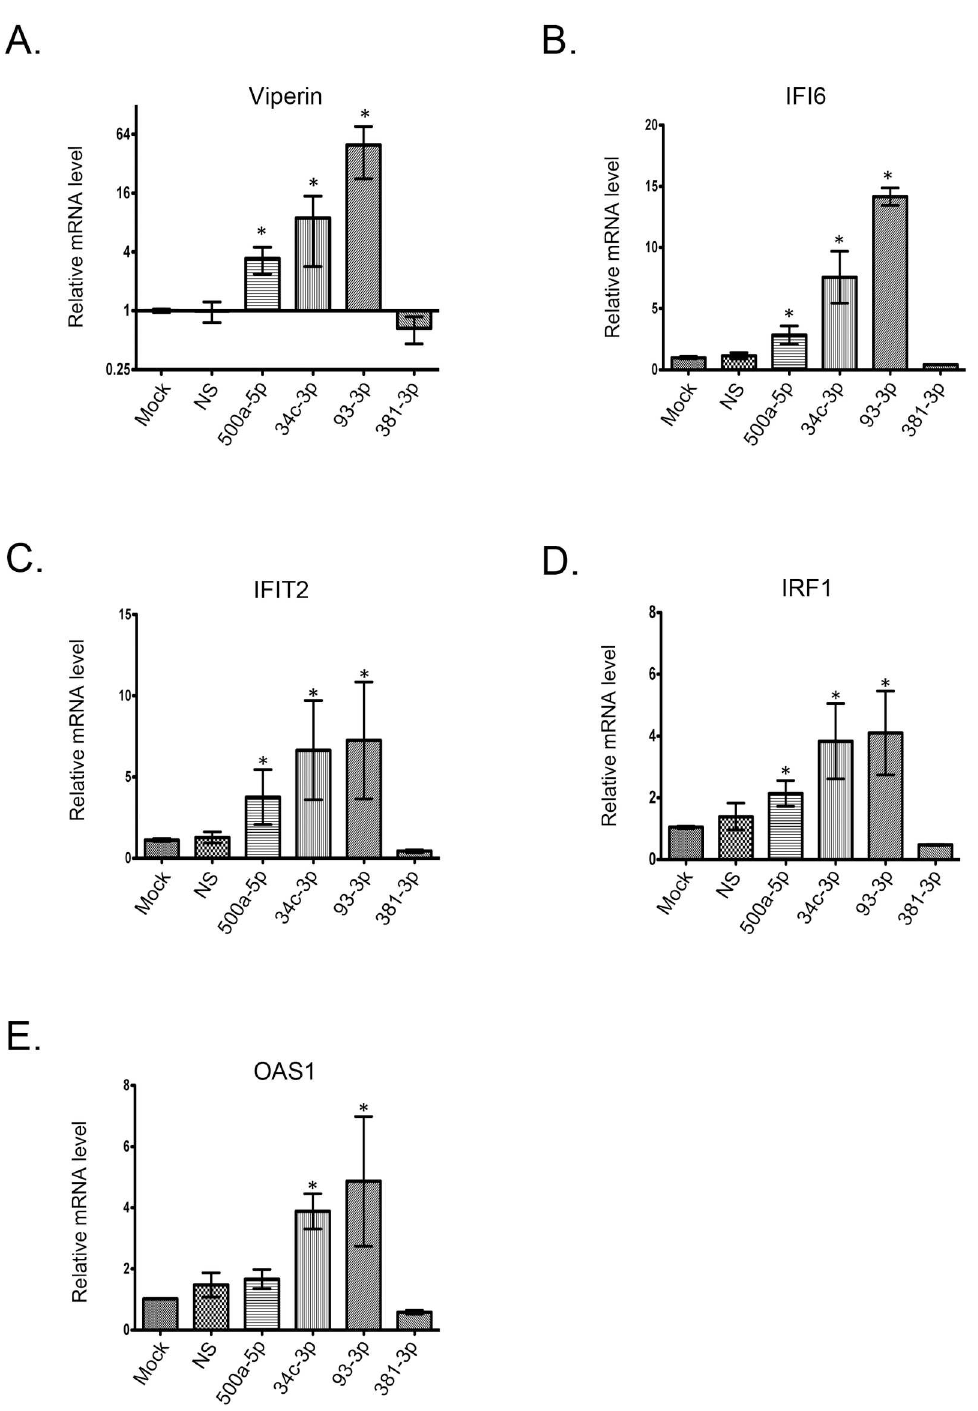
Fig 8. Transfection of miRNA mimics that target PEX mRNAsleads to increased levels of innate immune mRNAs. A549 cells were transfected with miRNA mimics (30 nM) for miR-NS, miR-500a-5p, miR-34c-3p, miR- 93-3p or miR-381-3p. Forty-eight hours later, total RNA was extracted from the cells for use in RT-PCR. Relative levels of innate immune mRNAs (Viperin (A), IFI6 (B), IFIT2 (C), IRF1 (D), and OAS1 (E)) from 3 independent experiments were determinedby RT-PCR from total RNA extracted from the samples. Error bars represent standard error of the mean.